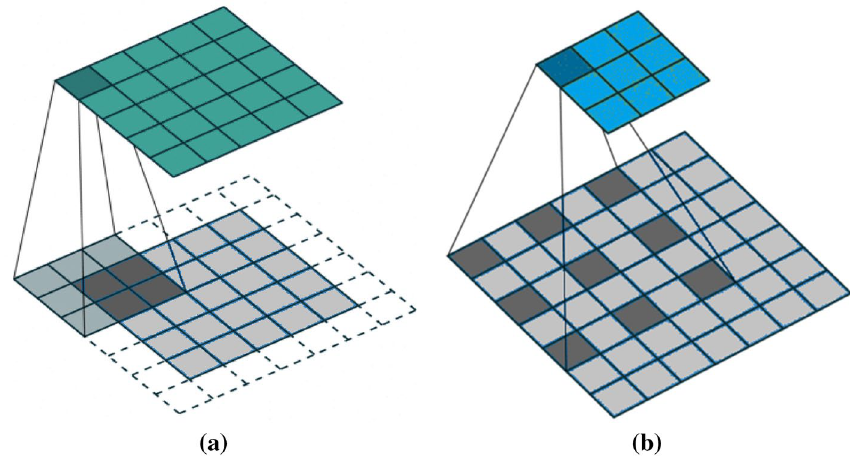
Figure 9. Represents the typical and atrous convolution ( a ) a typical convolution of kernel size = 3, stride = 1 and padding is used to retain the input image size; ( b ) an atrous convolution which has an additional parameter called dilation rate which deletes every alternate row and column.